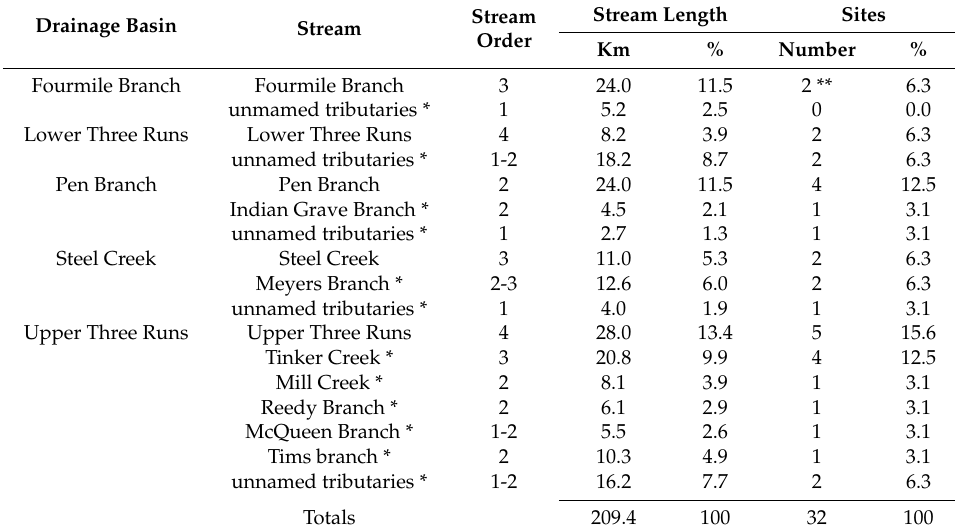
Table 5. Stratified design for estimating species richness. Sites were apportioned based on stream length in each stream order and drainage basin (see text). Table 4. Additive diversity partitioning of fish species richness in Sand Hill streams showing diversity components associated with progressively larger spatial scales.